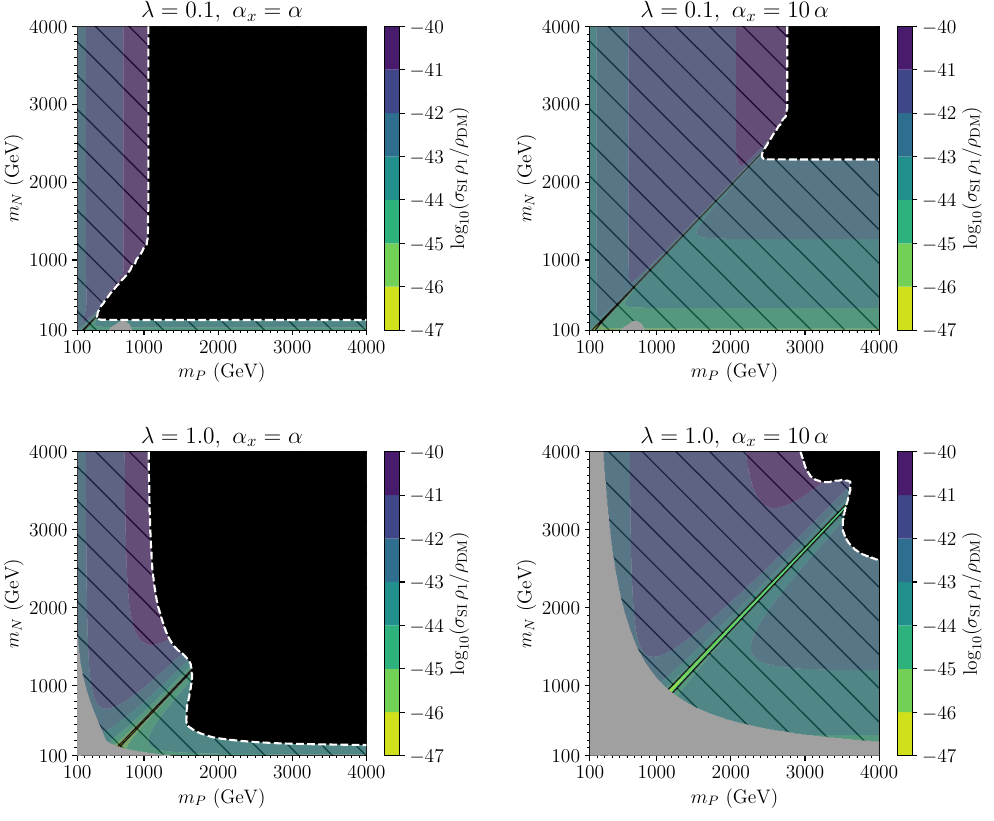
Figure 3 . Contours of the density-weighted spin-independent per nucleon cross section ( σ SI ρ 1 /ρ DM ) for the minimal connector theory in the m P – m N plane for λ = 0 . 1 , 1 . 0 (top and bottom) and α x = α, 10 α (left and right). The downward hatched regions are excluded by DM direct detection searches, the grey shaded regions show the combined exclusions from direct searches, and the black regions indicate where ψ 1 produces too much thermal dark